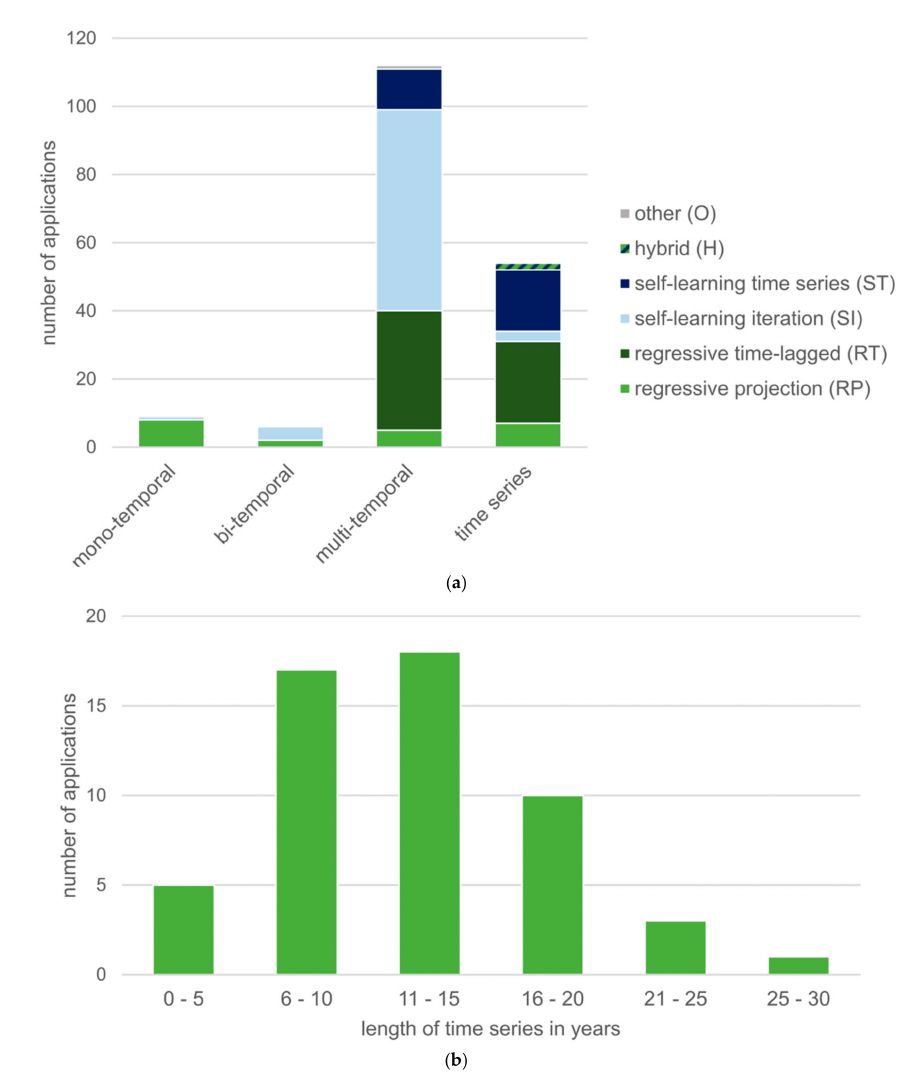
Figure 9. Temporal properties of the input data in EO-based forecasts: ( a ) Temporality of input data per forecasting method; ( b ) Number of applications of time series input data per time series length in